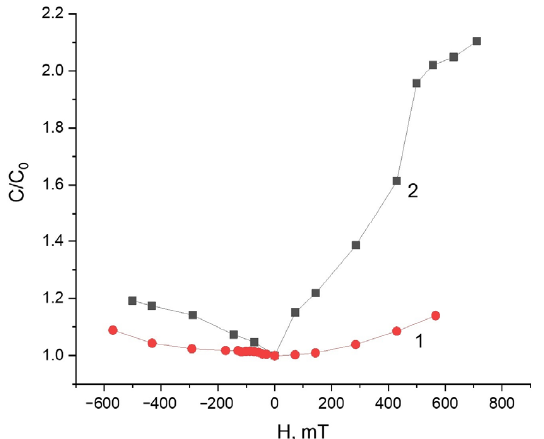
Figure 7. Magnetic field dependence of the relative capacitance of the capacitor filled with ( 1 ) an initial MAE–0 and ( 2 ) magnetized MAE–0–m, f = 1MHz.